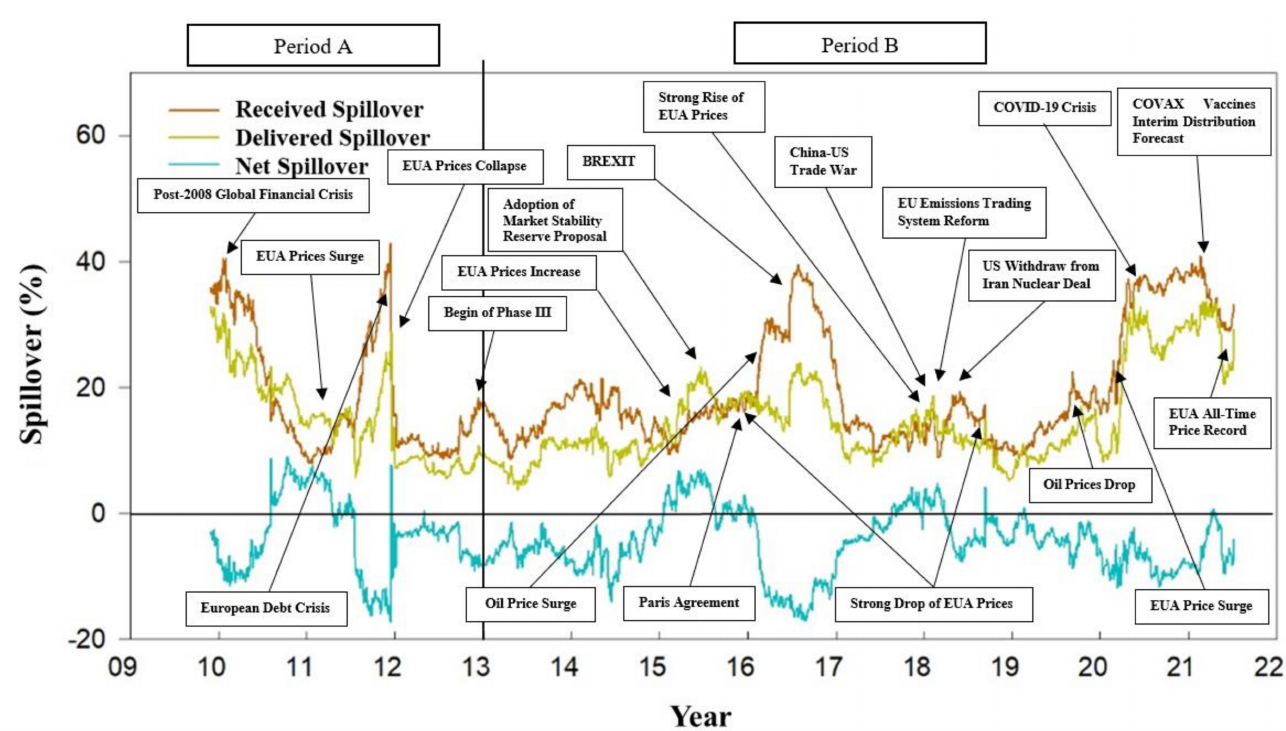
Figure 4. Spillover Plot of Received, Delivered and Net Return Spillovers of the Carbon Market in the “Carbon-Finance” Market System. Note: We plot the time series of the received, delivered and net return spillovers of the CE market in the “Carbon-Finance” market system based on 252-day rolling samples for the period from 1 December 2009 to 8 July 2021. The underlying variance decompositions are based on VAR models with lag orders of 7, as suggested by the AIC. The forecast horizon is 5 days. In the plot, we mark the major market and political events during the studied